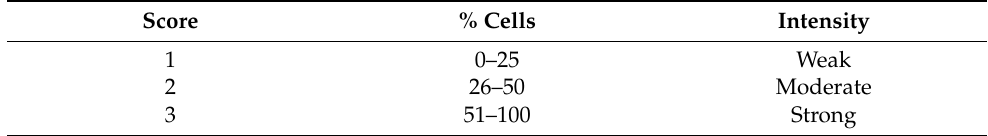
Table 4. Numeric scales to value COX-2 immunohistochemistry expression in groups (Pereira-Lucena et al., 2014)